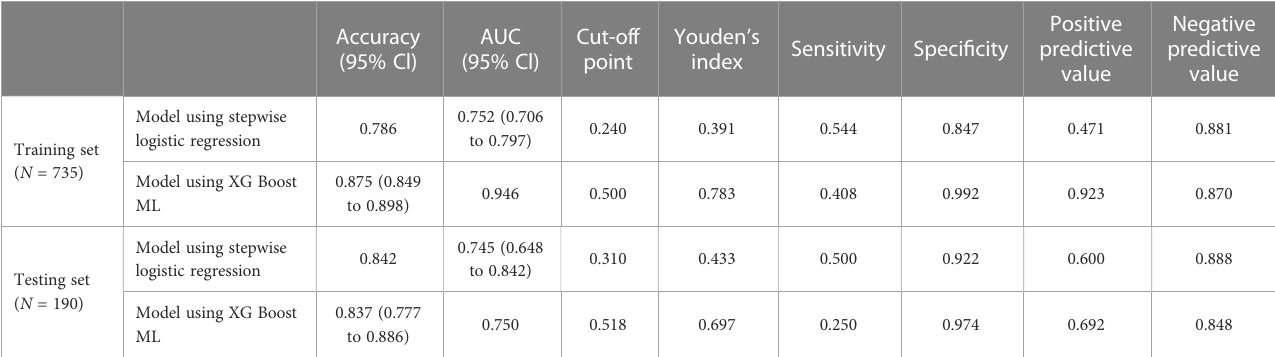
TABLE 4 Accuracy of the four prediction models.